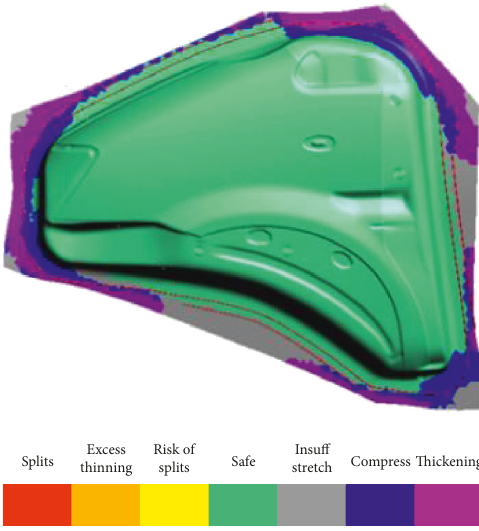
Figure 9: Thickening rate simulation